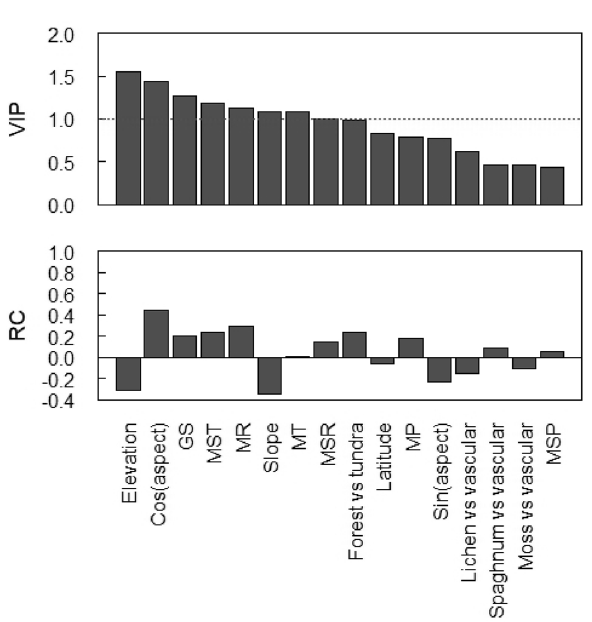
Figure 4. Variable importance in projection (VIP) values and regression coefficients (RC) of the explanatory variables included in the PLSR model. The dotted line indicates a VIP threshold above which predictors are considered important. Cos(aspect): south-north slope aspect, GS: mean length of the thermal growing season (days), MST: mean summer temperature (°C), MR: mean solar radiation (Wm 2 s −1 ), MT: mean temperature (°C), MSR: mean summer solar radiation (Wm 2 s −1 ), MP: mean precipitation (mm), Sin(aspect): west–east slope aspect, MSP: mean summer precipitation